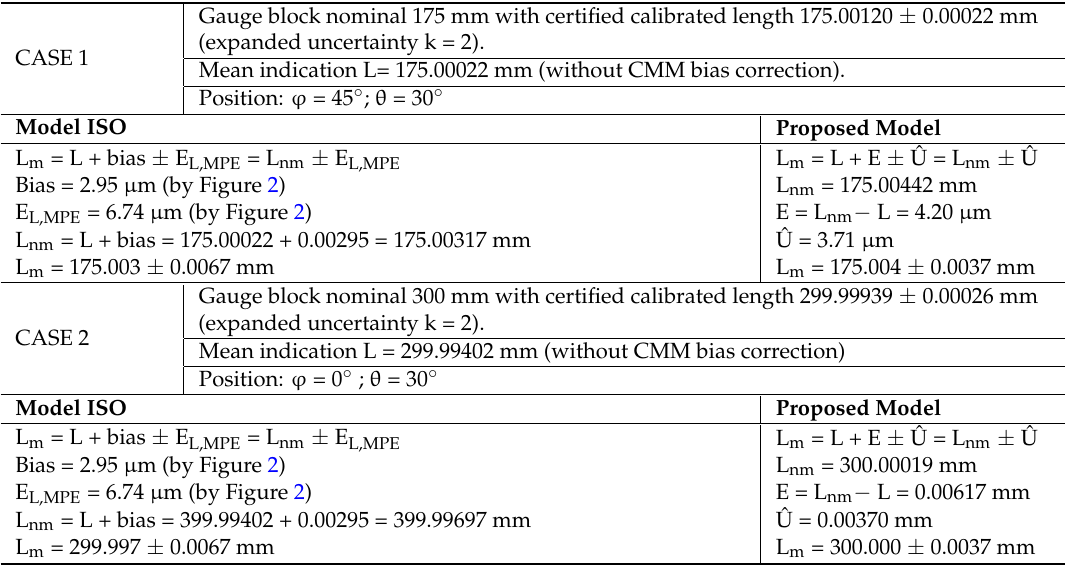
Table 1. Length tests from calibrated artefacts.